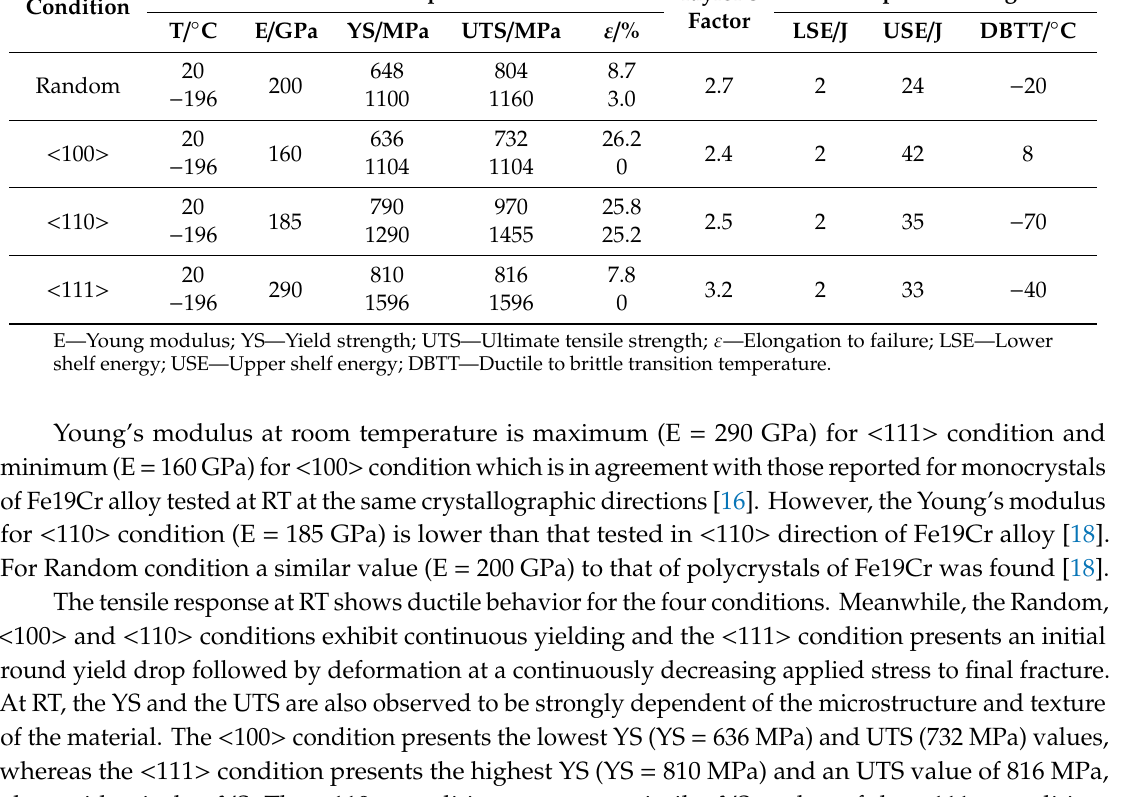
Figure 4. Nominal tensile stress-strain curves at − 196 °C and room temperature of the four processing conditions: ( a ) random, ( b ) < 100 > , ( c ) < 110 > and ( d ) < 111 > . Table 4. Results of tensile and bending impact tests of Fe20Cr4.5Al alloy in di ff erent conditions.